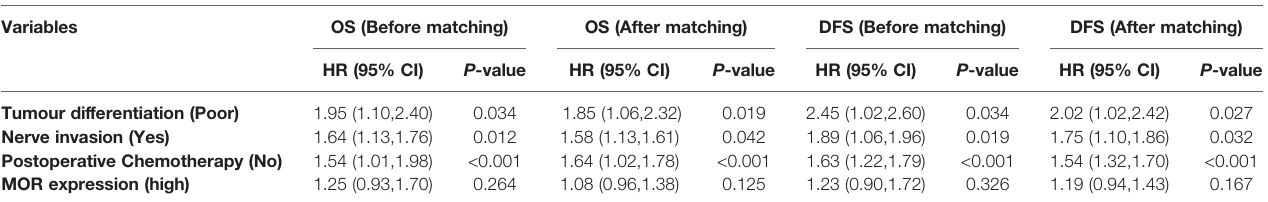
TABLE 3 | Multivariable Cox proportional of OS and DFS.